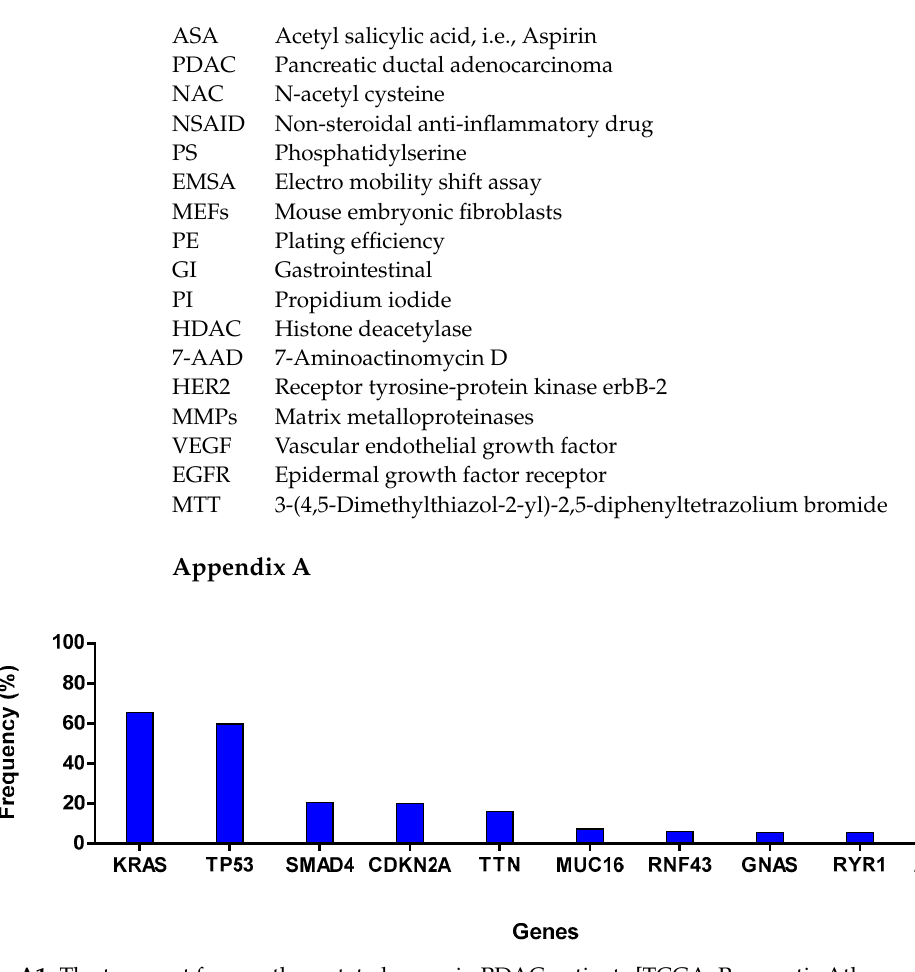
Figure A3. Cell viability of Panc-1 cells in response to increasing Gemzar (gemcitabine) exposure concentrations. Growth curves were plotted by non-linear regression using the variable slope equation in GraphPad prism software. Data represented as mean ± SD. References 1.